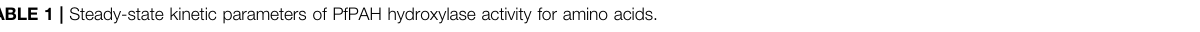
TABLE 1 | Steady-state kinetic parameters of PfPAH hydroxylase activity for amino acids. Substrates